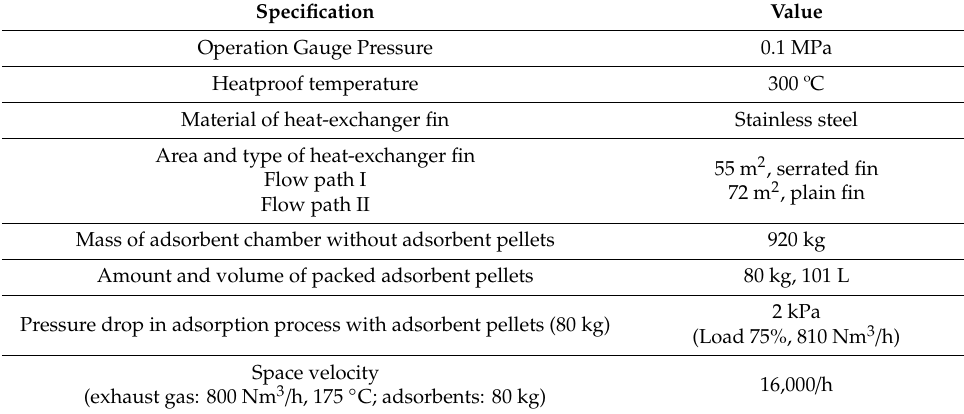
Table 3. Specifications of the adsorption chamber.